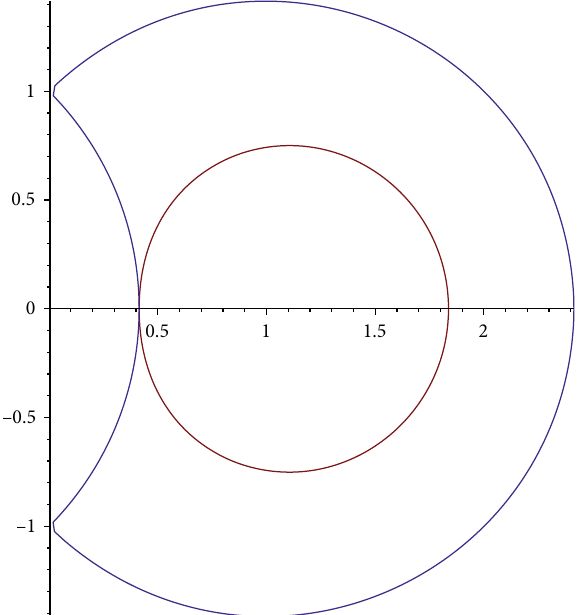
ffiffiffi p 2 , β = 1 : 98743